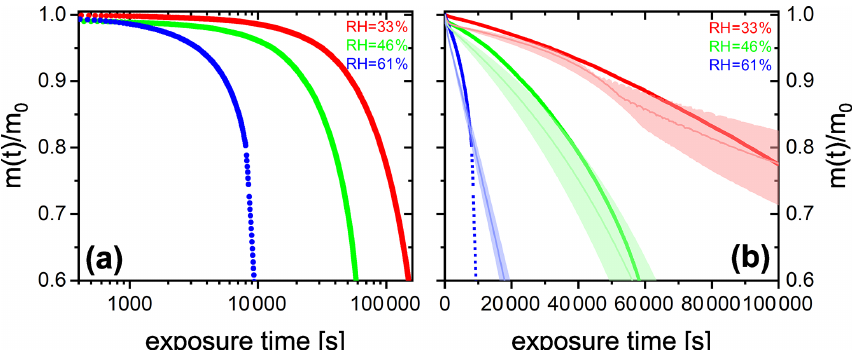
Figure 6. (a) Fe III ( Cit )/ CA (molar ratio 0.05) particle mass change with irradiation time (log scale) at different RH: 33% (red), 46% (green), and 61% (blue). The irradiation wavelength was 375nm, its intensity was 0.25Wcm − 2 , and the experimental temperature was 293.5K. (b) EDB experimental data in (a) with PRAD outputs at corresponding RH (with ± 2% RH uncertainty shown as shaded area) as a function of irradiation time (linear scale).